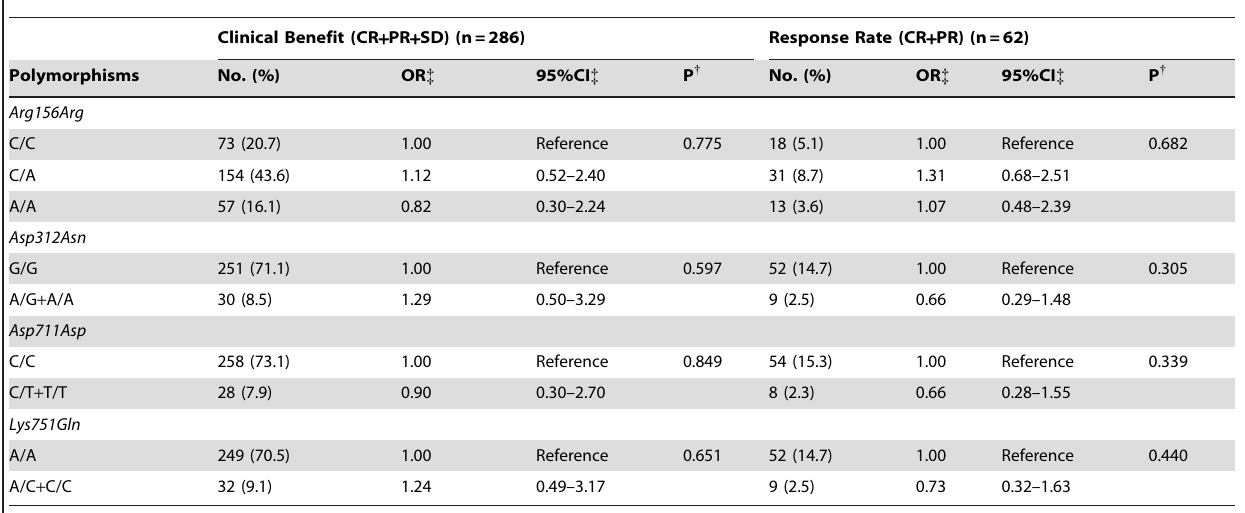
Table 2. XPD Polymorphisms and Tumor Response by Univariate Analysis.